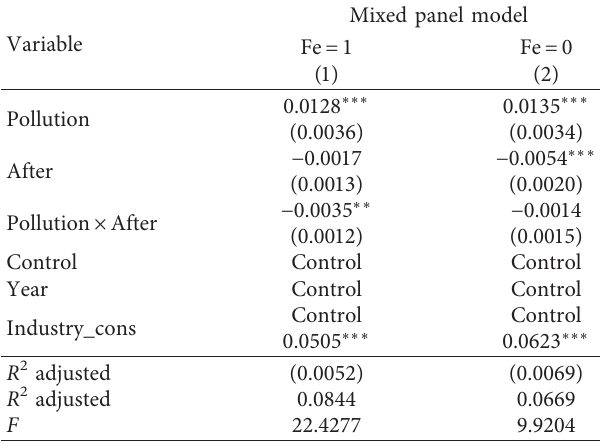
Table 9: Test of the heterogeneity of the financial ecological